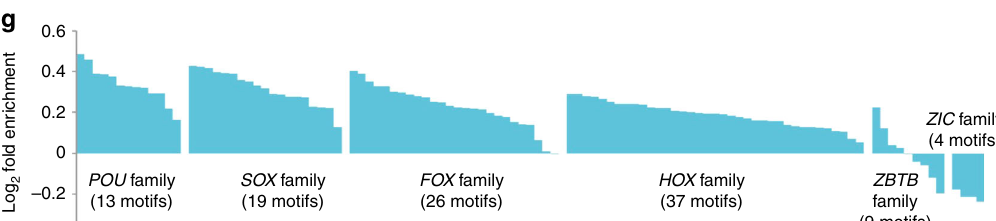
(Fig. 5a and Supplementary Data 5a), prostate epithelial (PrEC) cell (Supplementary Fig. 9a and Supplementary Data 5b), CD4 + T cell (Supplementary Fig. 10a, Supplementary Data 1a), primary mammary epithelial (HMEC) cell (Supplementary Fig. 12a and Supplementary Data 5c), and human epidermal melanocytes (HEM) cell (Supplementary Fig. 14a and Supplementary Data 5d). BGRDs in these cells were enriched at oncogenes too.